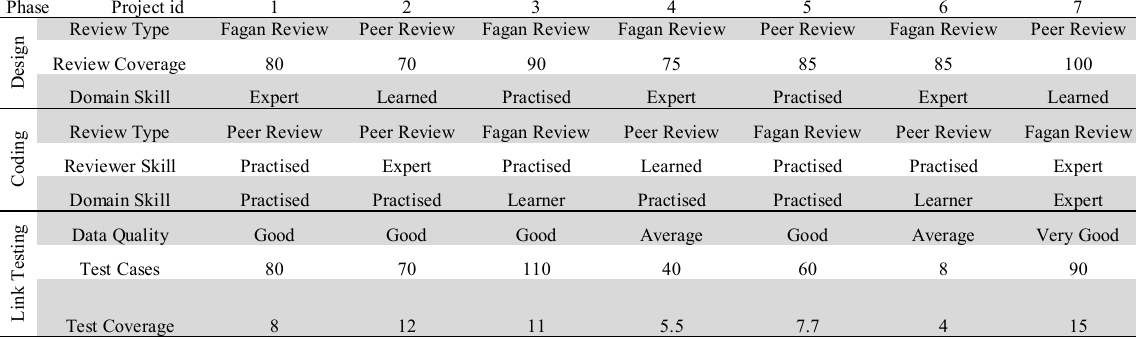
Control variable values used for validation